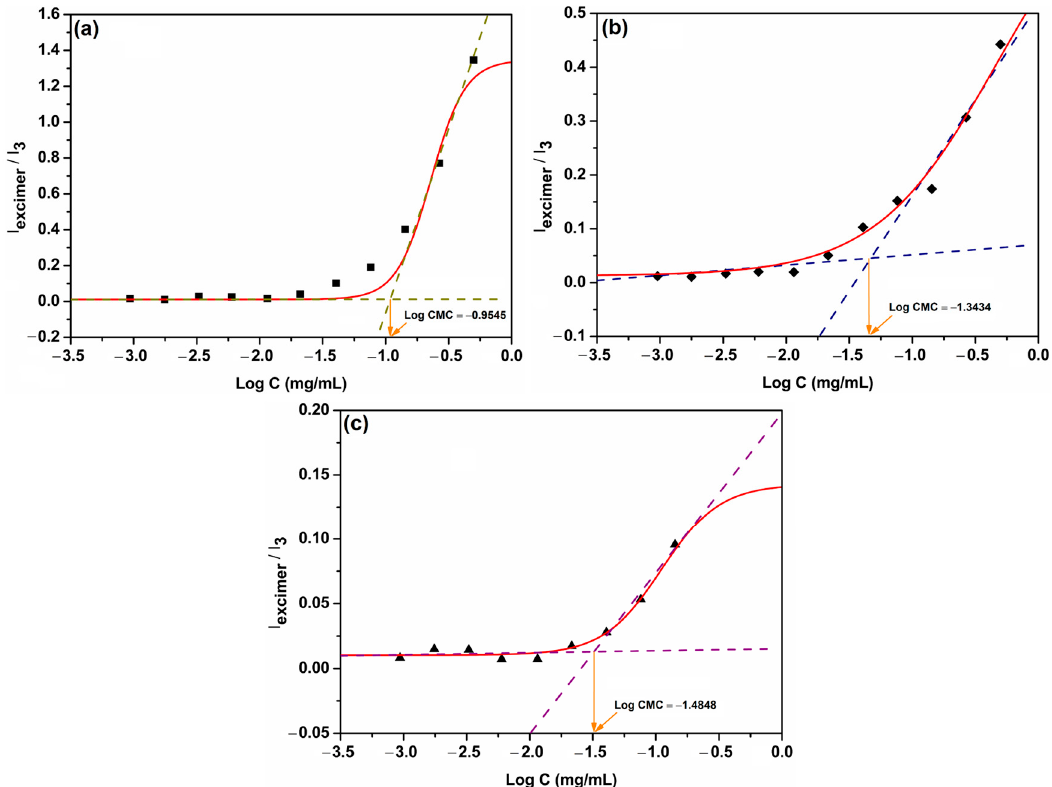
Figure 1. The ratio of the intensity (I excimer /I 3 ) of the pyrene to the logarithm of the concentration of the copolymers PEG2K-PHis20 ( a ), PEG2K-PHis26 ( b ), and PEG2K-PHis32 ( c ). The decrease in CMC values from 0.111 mg/mL to 0.032 mg/mL with the increase